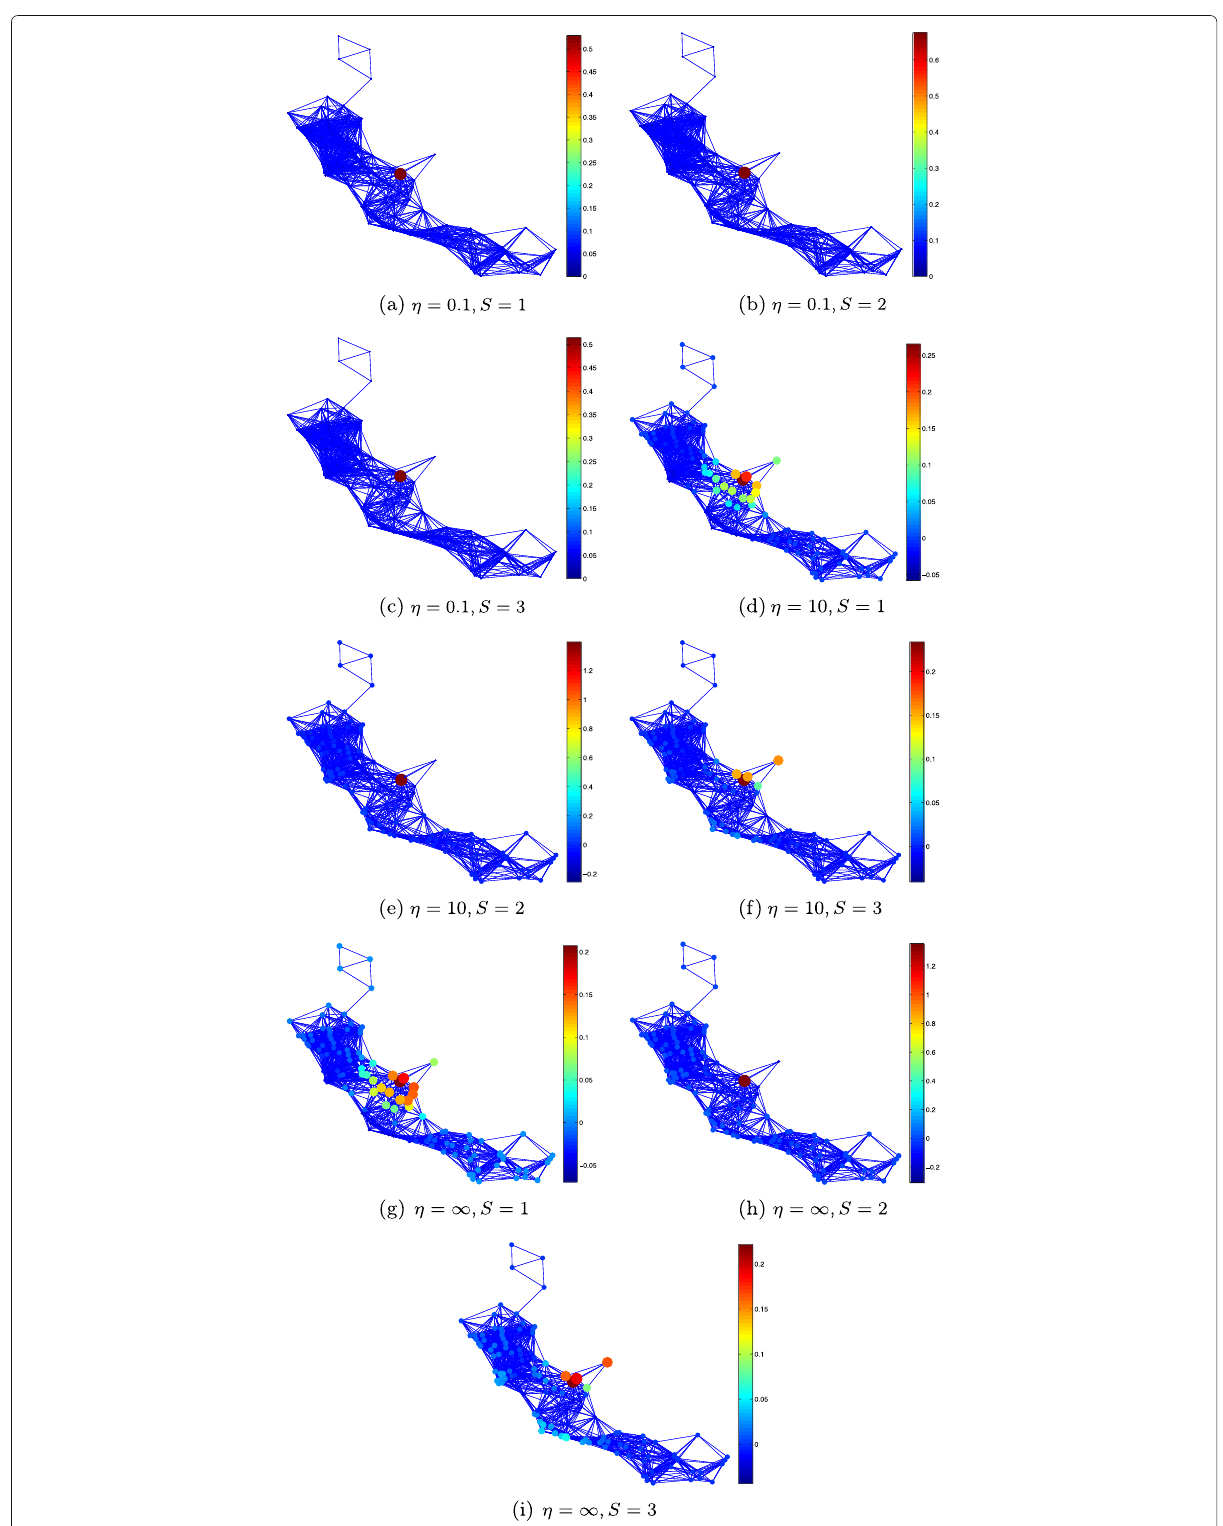
Fig. 8 Illustration of the atoms learned with different values of η , placed at node 10 of the cimis graph. The more we penalize the quantization error, the more localized are the atoms. a η = 0.1; S = 1. b η = 0.1; S = 2. c η = 0.1; S = 3. d η = 10; S = 1. e η = 10; S = 2. f η = 10; S = 3. g η = ∞ ; S = 1. h η = ∞ ; S = 2. i η = ∞ ; S =